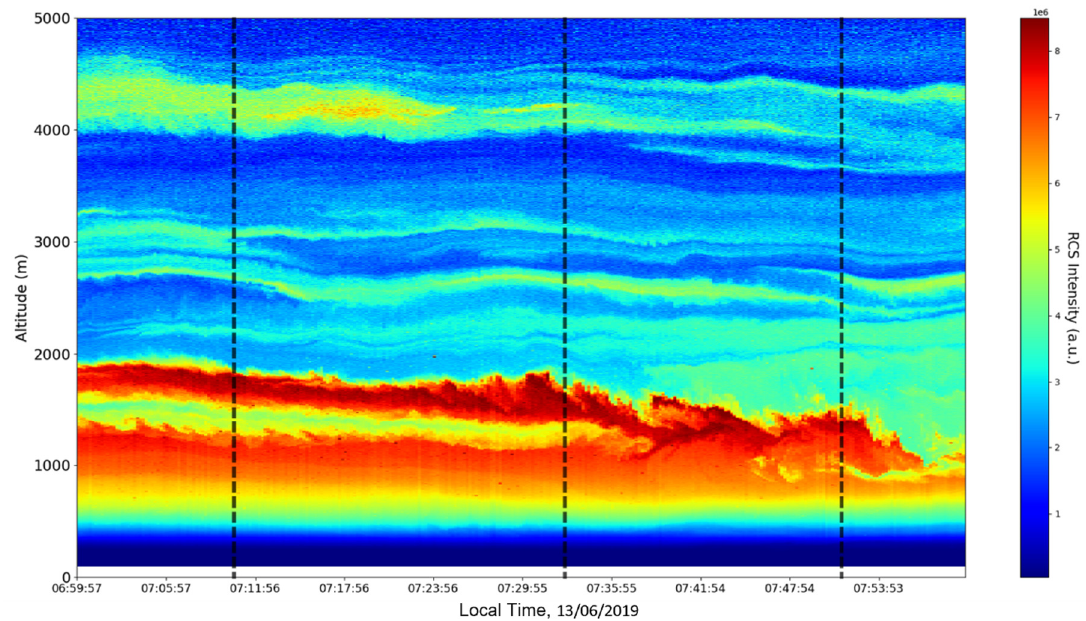
Figure 2. RCS timeseries, Bucharest, Romania, 13 June 2019 (zoomed-in, inferior region of interest).